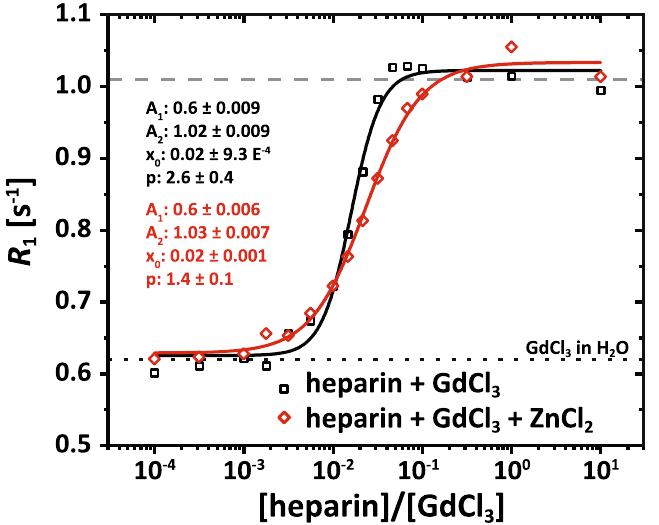
Figure 4. R 1 titration curve of 25 µM GdCl 3 with different heparin concentrations (c.f. supplemental Table S2) in the absence (black squares) and presence (red diamond) of ZnCl 2 (833 µM) at 9.4 T and 25 °C. Both curves start at R 1 ≈ 0.6s − 1 , which matches the expected relaxivity of 25 µM of free GdCl 3 in H 2 O (dotted black line). For increasing concentration ratios, R 1 of both curves increases until approaching a new plateau value of R ≈ 1.02s − 1 at concentration ratios of about 10 –1 and 1 in the absence and presence of ZnCl 1